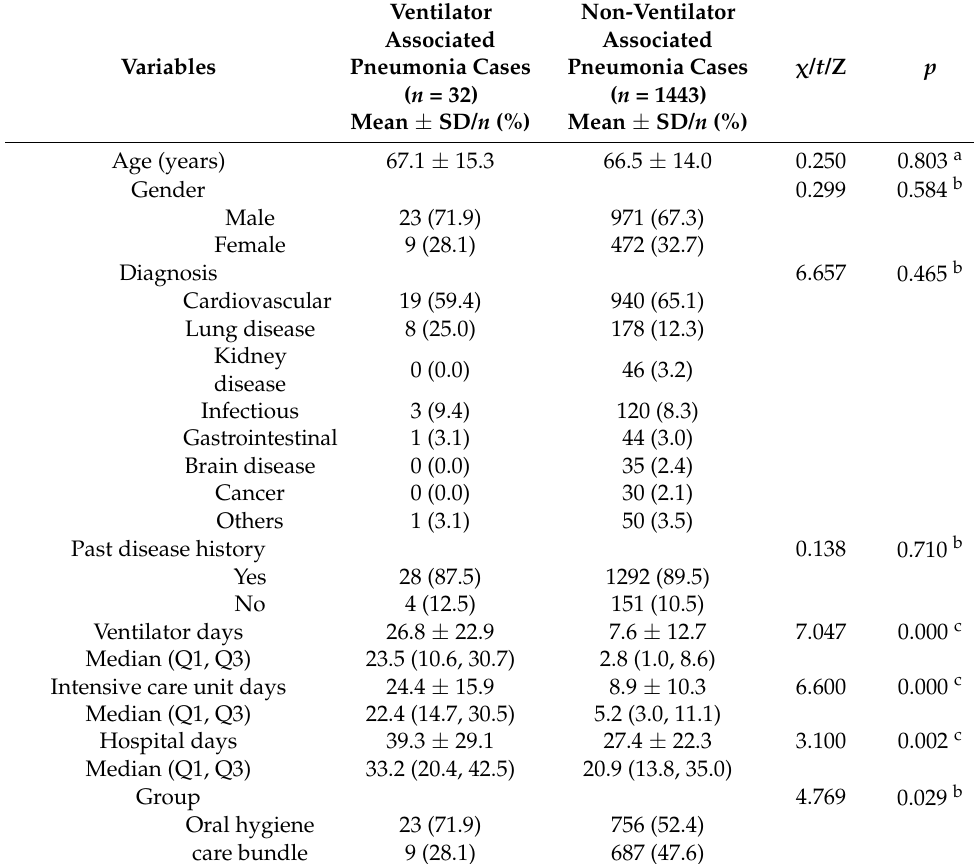
Table 3. Ventilator-Associated Pneumonia Related Factors ( N =